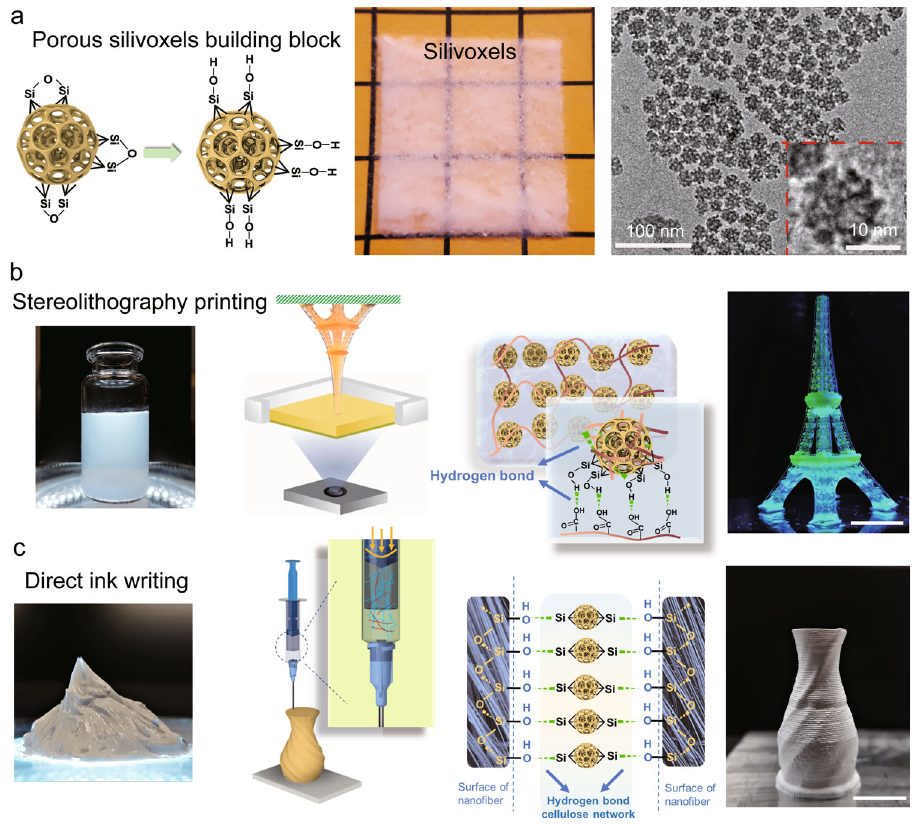
Fig. 1 | Porous silivoxels for additive manufacturing of thermal insulation materials. a The porous silivoxel powders as the feedstock, and the slurry of polymer additives and porous silivoxelsasthe ink for additive manufacturing. The corresponding TEM image of porous silivoxels. b Mechanically tunable silivoxels through tuning the hydrogen-bonding polymer chains and printed via